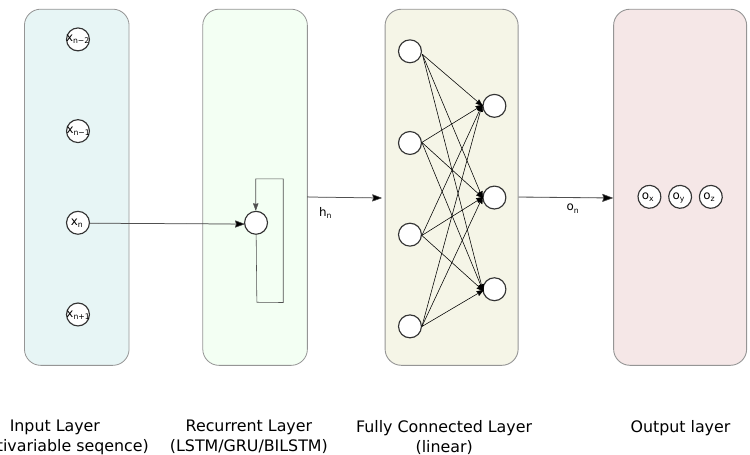
Figure 6. Proposed RNN-FC architecture for the regression